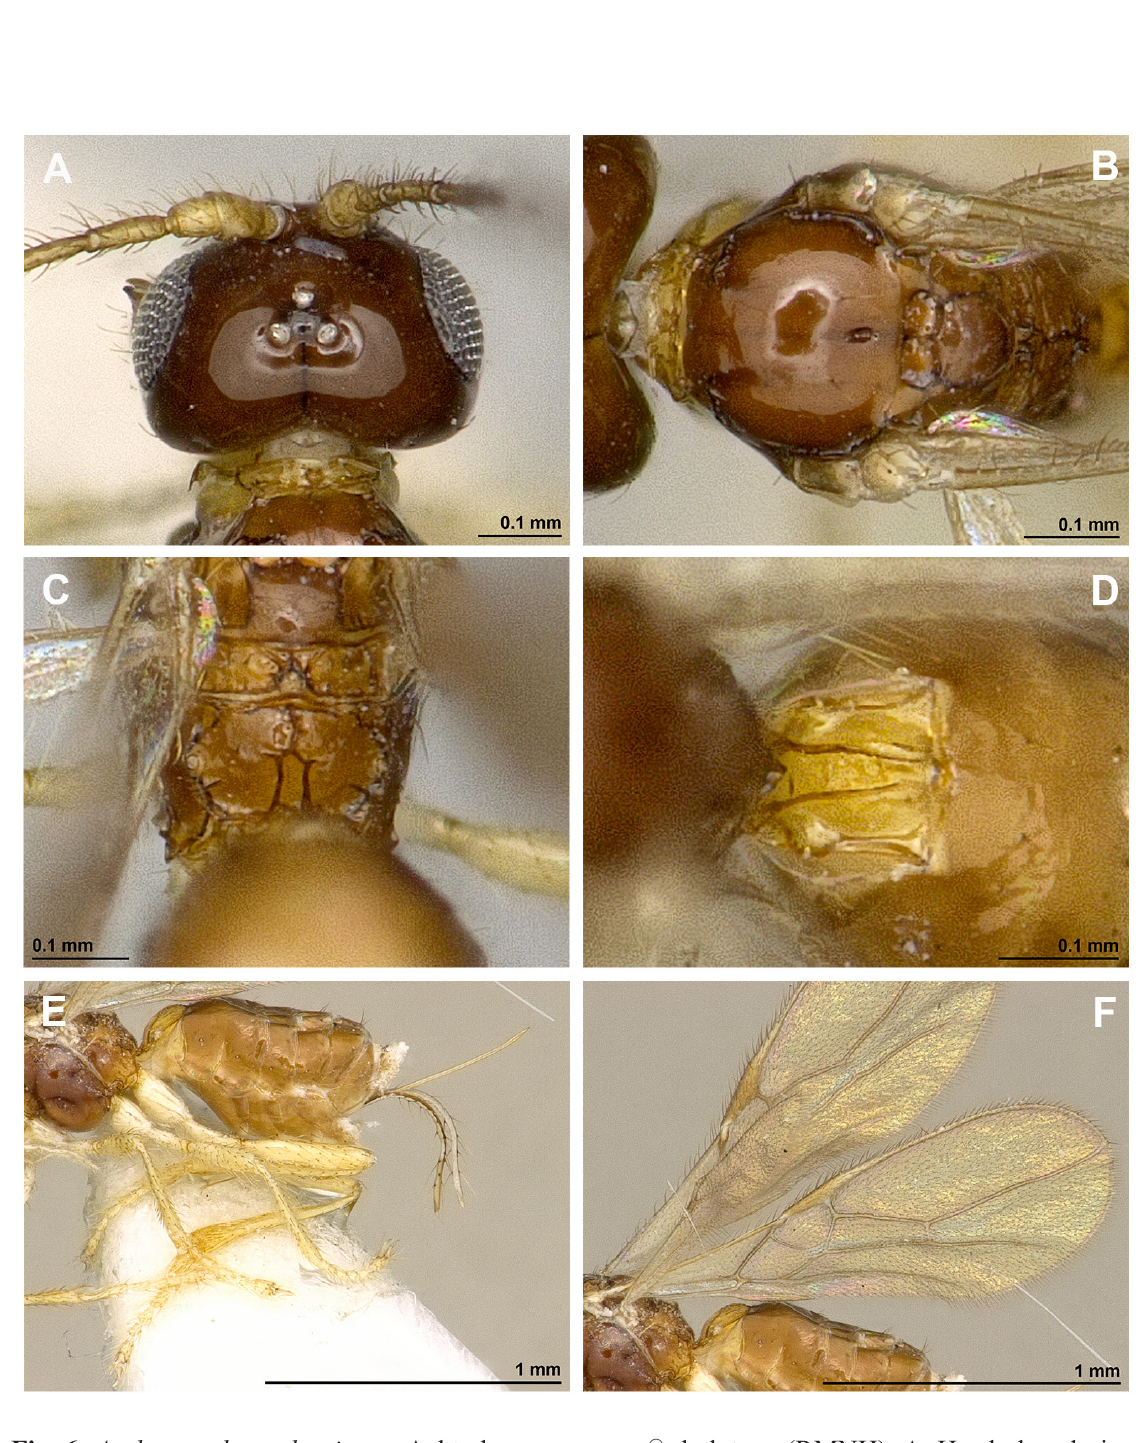
Fig. 6. Asobara caboverdensis van Achterberg, sp. nov., ♀, holotype (RMNH). A . Head, dorsal view. B . Mesoscutum, dorsal view. C . Propodeum, dorsal view. D . First metasomal tergite, dorsal view. E . Hind leg, metasoma and ovipositor, lateral view. F . Fore and hind